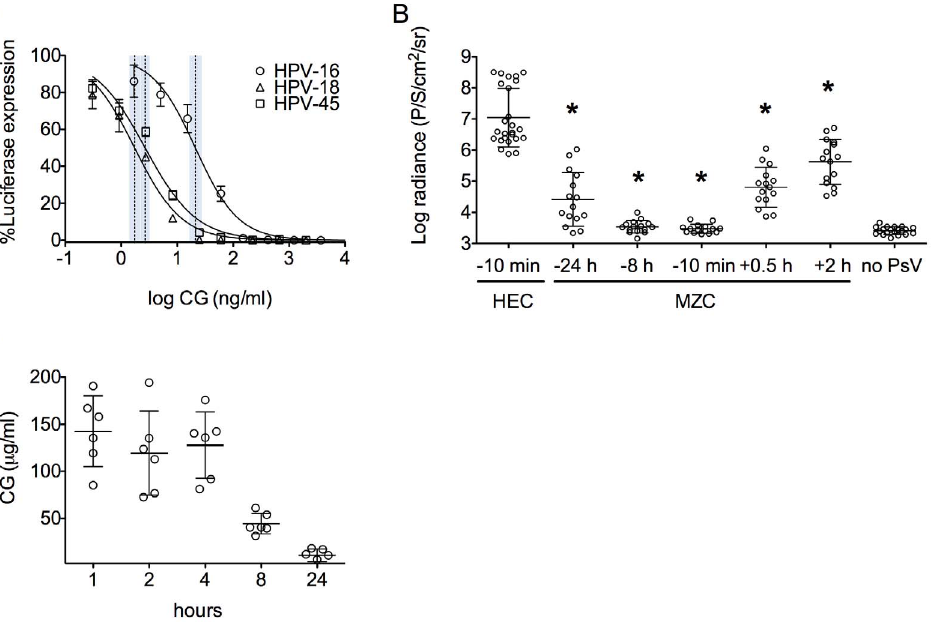
Figure 6. MZC has potent anti-HPV activity invitro and prevents HPV-16 PsV vaginal infection in mice. A) The anti-HPV-16 (open circles), 18 (open trianbles) and 45 (open squares) IC 50 values (shown as a vertical dotted line within the 95% confidence interval) were estimated using the luciferase assay in HeLa cells. All gel dilutions were tested in triplicate. B) Depo-treated Balb/C mice were given the indicated formulations (HEC placebo or MZC) intravaginally at different time points before HPV-16 PsV challenge (15 animals/treatment). In vivo luciferase expression was measured 24 h after challenge using the IVIS Lumina and is expressed as mean luminescence in photons per second per centimeter square per steridian 6 SD (*P , 0.05 vs. HEC, Mann Whitney U test). C) CG levels (mean m g/ml 6 SD) in vaginal washes from mice treated intravaginally with MZC were measured by ELISA at 1, 2, 4, 8 and 24 h post-gel (n=6 per time point).